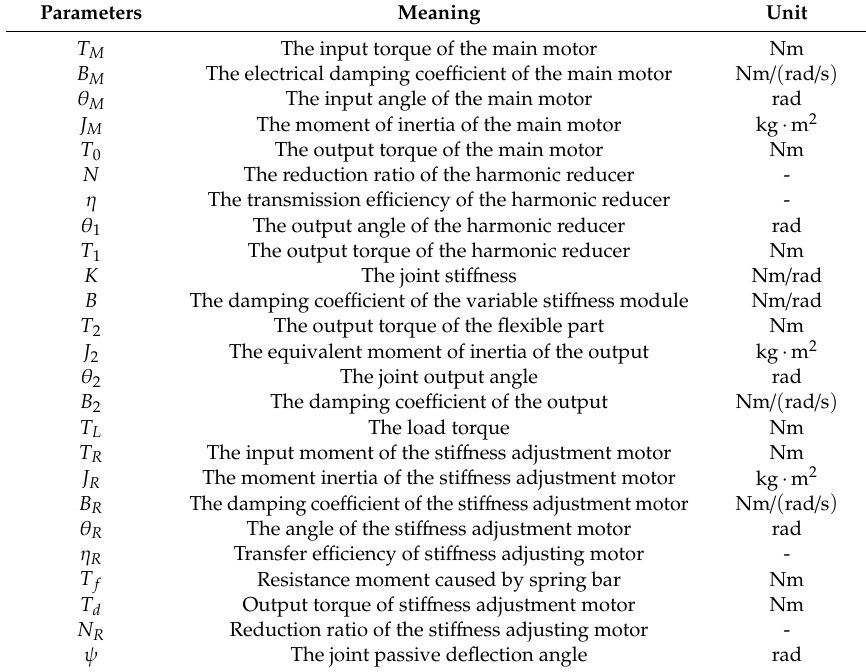
Table 4. The meaning of each parameter in the dynamical model of SCM-VSJ.